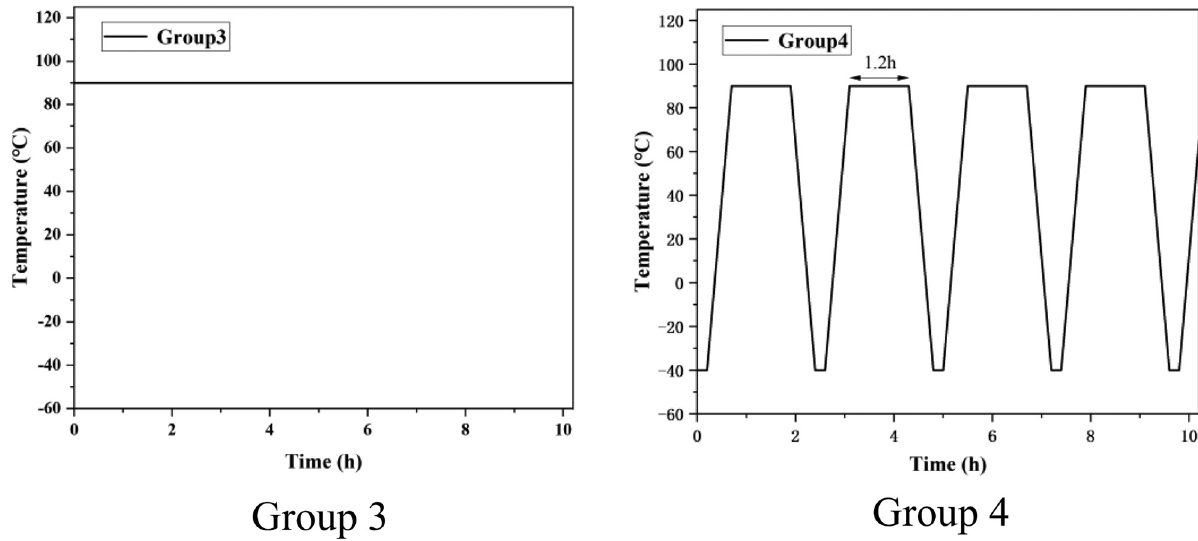
Figure 3: Temperature cycle control aging experiment -